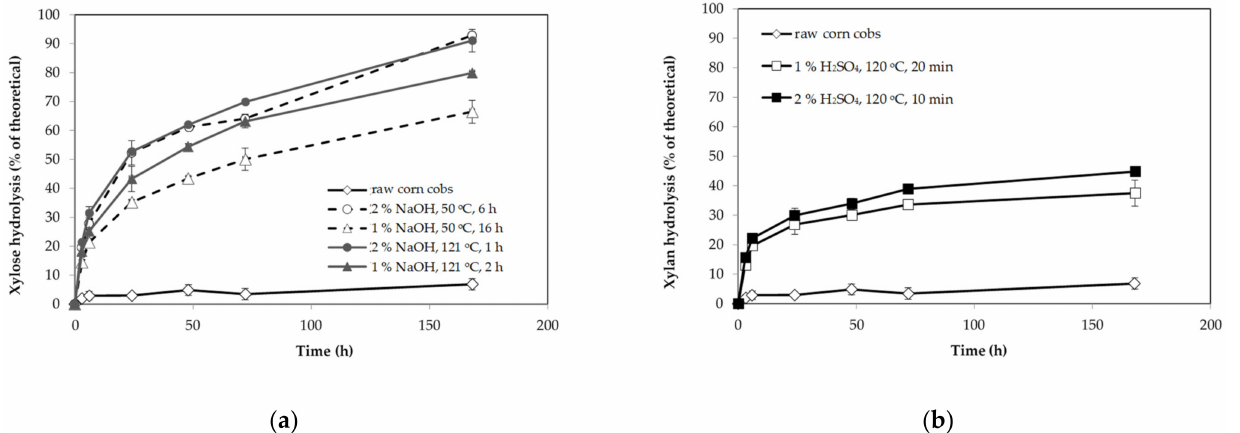
Figure 3. Efficiency of enzymatic hydrolysis of xylan from raw and pretreated corn cobs with sodium hydroxide: (( a ) 1% NaOH, 50 ◦ C, 16 h; 2% NaOH, 50 ◦ C, 6 h; 1% NaOH, 121 ◦ C, 2 h and 2% NaOH, 121 ◦ C, 1 h) and sulfuric acid; (( b ) 2% H 2 SO 4 , 120 ◦ C, 10 min and 1% H 2 SO 4 , 120 ◦ C, 20 min)